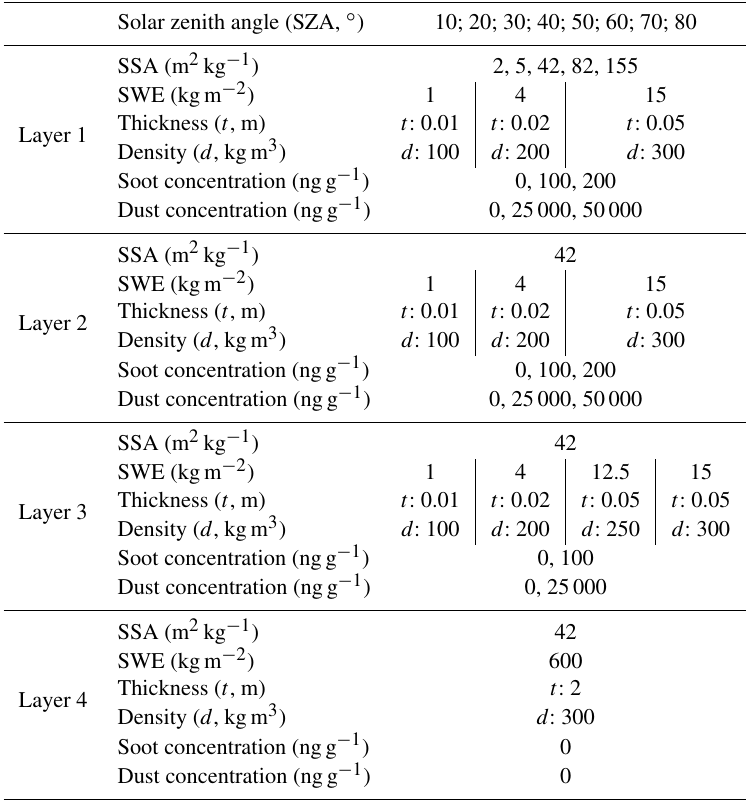
Table 3. Snow properties of simulations. The spectral albedo is calculated for eight values of SZA and five values of SSA for the snowpack first layer. For snow without LAPs, the SWE values are provided for the first three layers of the snowpack. For snow with LAPs, the SWE and the light-absorbing particle concentration (for soot and dust) are provided for the first two layers of the snowpack. For layer 3, the values of all input parameters, besides soot and dust contents, are constant. For layer 4, all input parameters are constant. Solar zenith angle (SZA, ◦